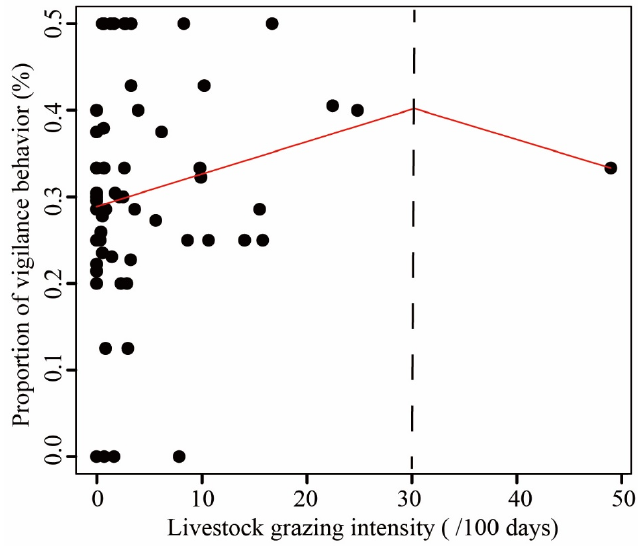
Figure 2. The relationship between livestock grazing intensity and the proportion of vigilance behaviour of Reeves’s Pheasant. A threshold in livestock grazing intensity is represented by the black-dashed line.